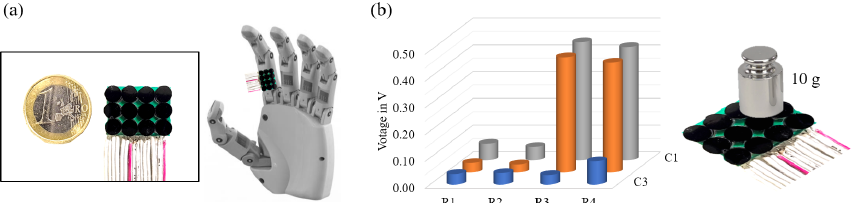
Figure 7. (a) 4 × 3 tactile sensor array implementation in robotic finger. (b) Sensor response demonstrating the spatial resolution and low- pressure sensing capability.